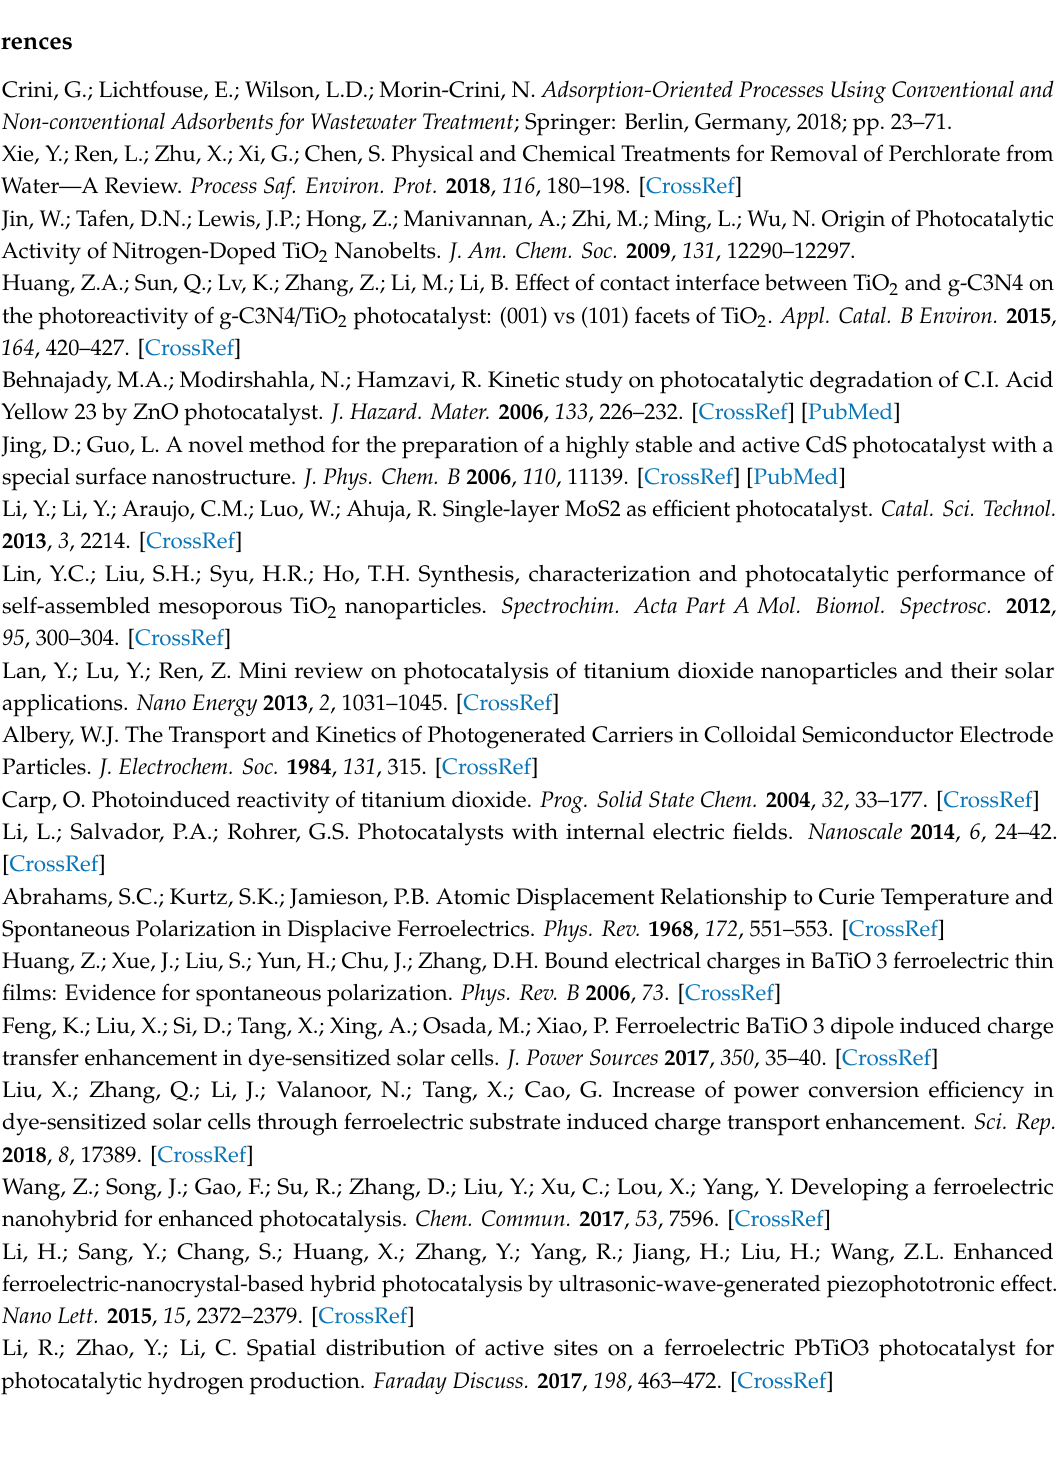
hydrolysis reaction Figure S4. Line-scan EDS profile (b) along the red dot dash line crossing the BaTiO 3 -TiO 2 core-shell heterostructure (a). Figure S5. Absorption spectra of RhB solution in the presence of BaTiO 3 -TiO 2 core-shell heterostructures (1.2:1) under UV light irradiation. Inset shows color changes of the RhB